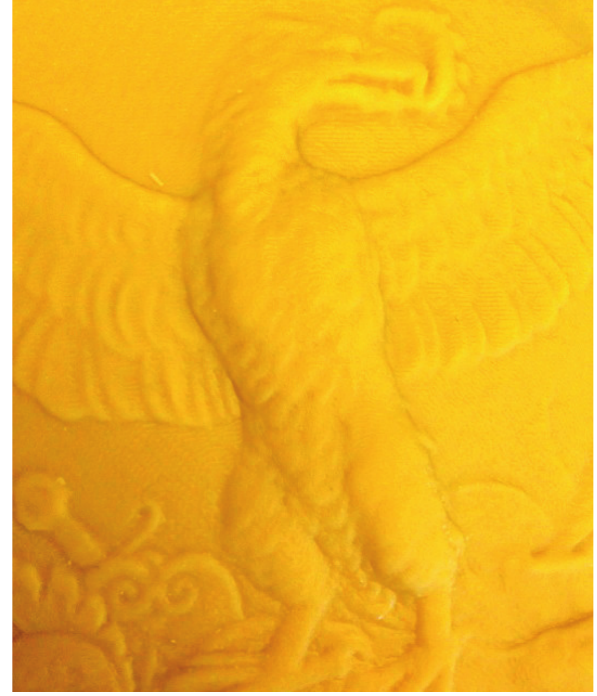
Figure 9: A detail of the armor at scale